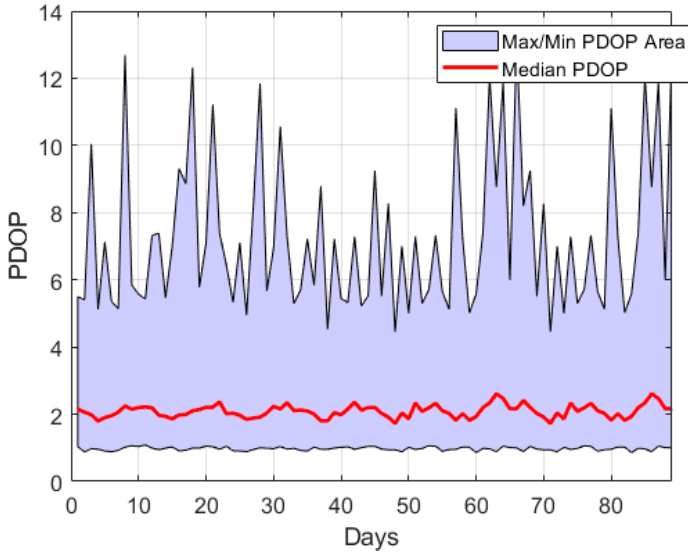
Figure 9. Daily maximum/minimum and median PDOP.